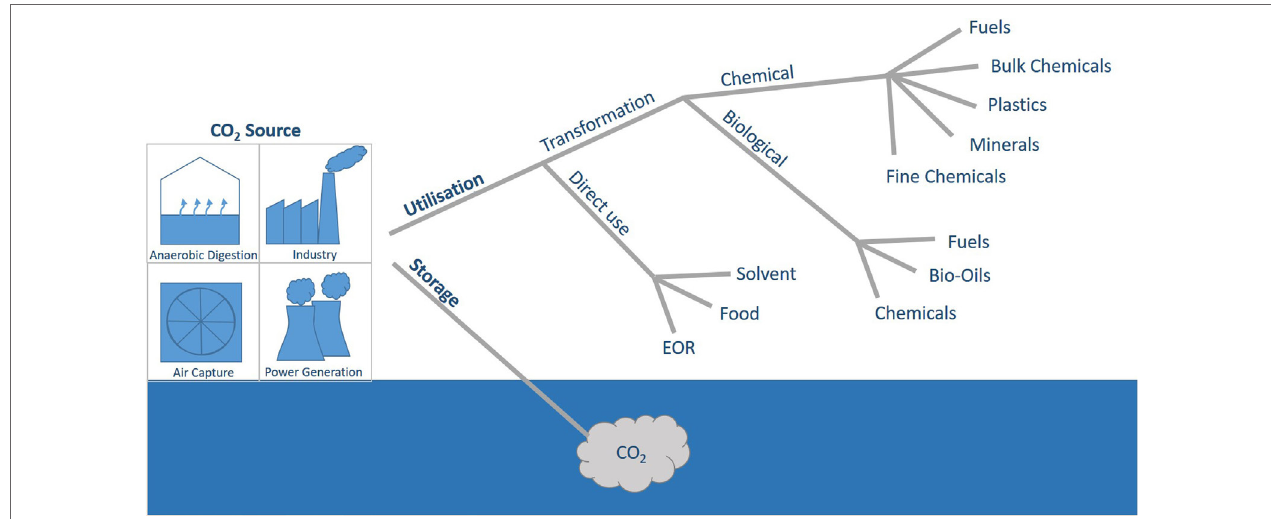
FigURe 1 | Carbon dioxide storage and utilisation options . Carbon dioxide from point source emitters (e.g., fossil fuel power generation or other large industrial emitters) or via direct air capture or biological processes can be geologically stored ( via carbon capture and storage) or used. Use of CO 2 can be direct (e.g., for use in “enhanced oil recovery”) or the captured CO 2 can be transformed via chemical or biological processes for use as a carbon feedstock (e.g., for the manufacture of fuels, chemicals, plastics,